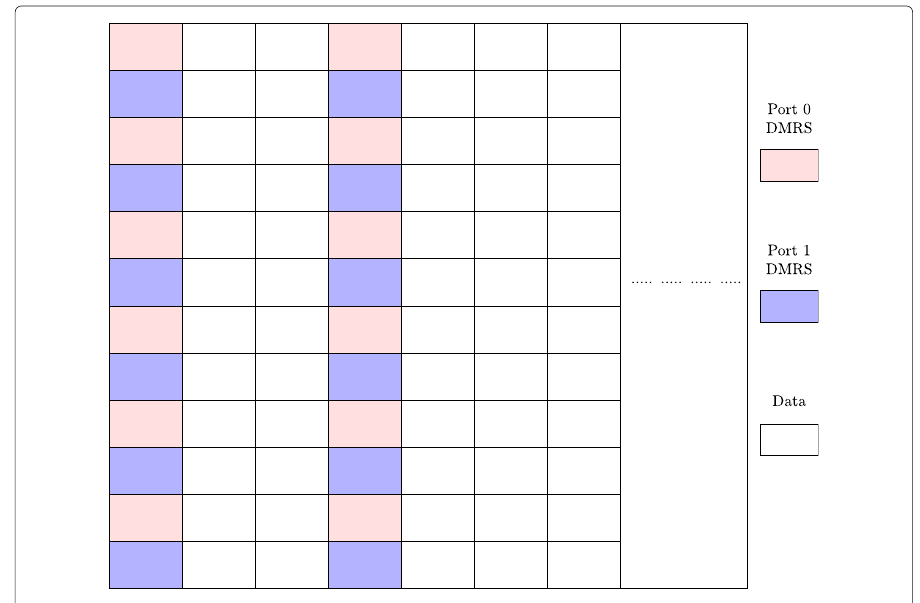
Fig. 4 DMRS and data symbols in a OFDM resource